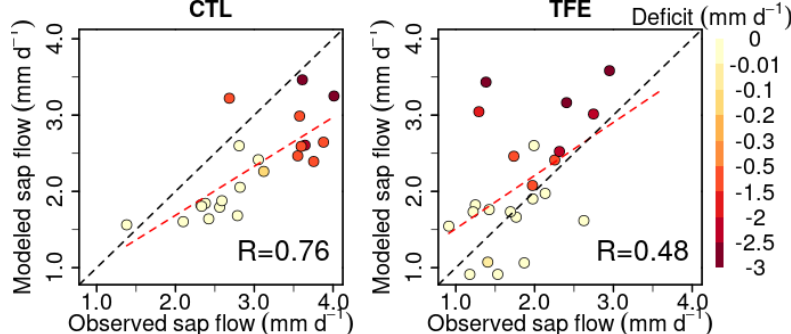
Figure 2. Modeled (ORCHIDEE-CAN-NHA) vs. observed sap flow (monthly average values are displayed). The color of points indicates water deficit (negative difference between precipitation and evapotranspiration) with darker color meaning more severe water deficit. The dashed black line is the 1 : 1 line. The dashed red line is the best fit between modeled and observed sap flow.